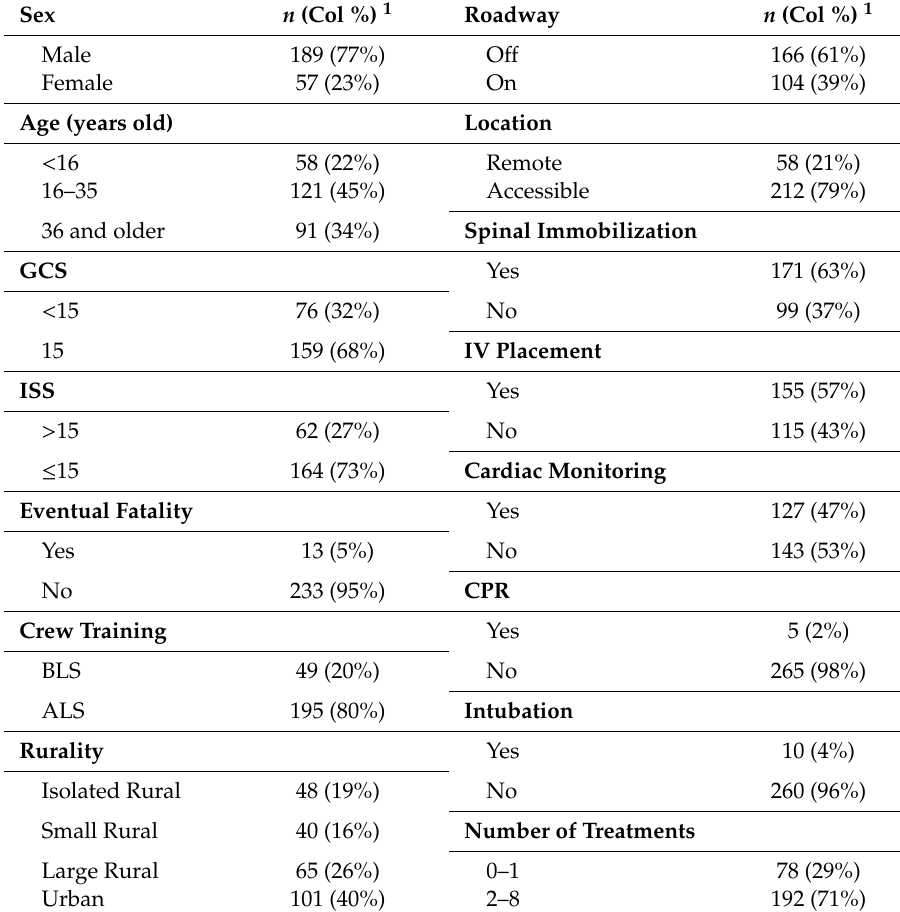
Table 1. Patient, injury severity, crew, crash location, and treatment characteristics of emergency medical services (EMS) responses to all-terrain vehicle crashes recorded in the Iowa EMS Registry (2004–2014) and identified using the Iowa O ff -Highway Vehicle Database (2004–2013) and the Iowa State Trauma Registry for